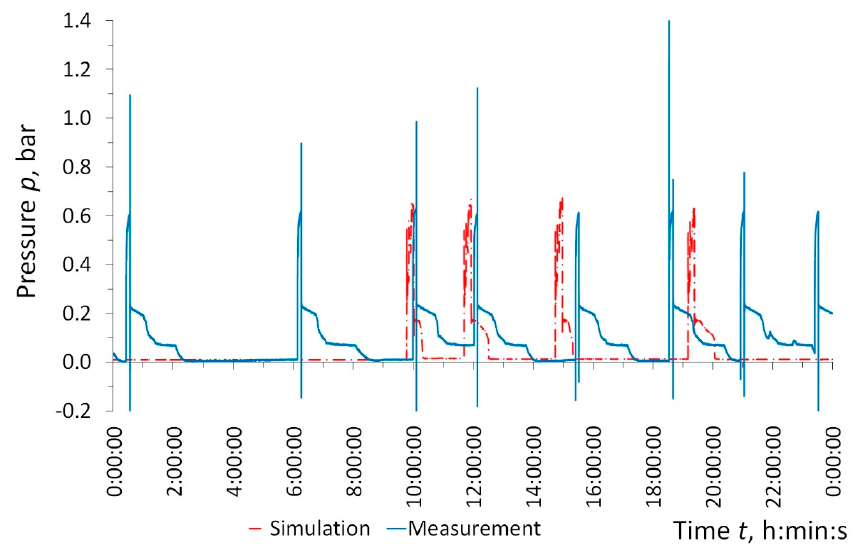
Figure 14. Pressures of wastewater in the force main just downstream of PS_2 measured on 20 October 2016 and simulated for day 3 using the SWMM 5.1.